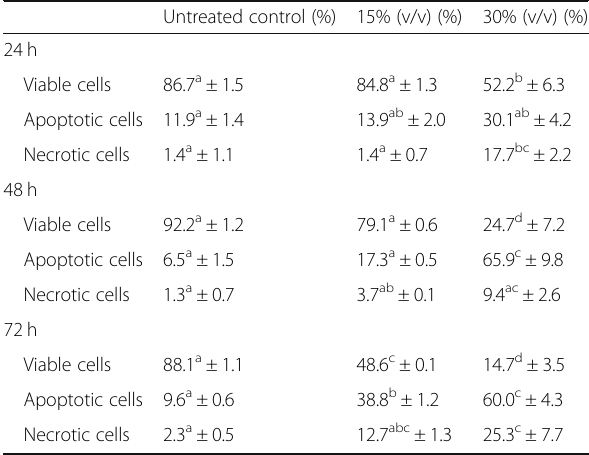
Table 3 Cell death modes of MCF-7 cells induced by